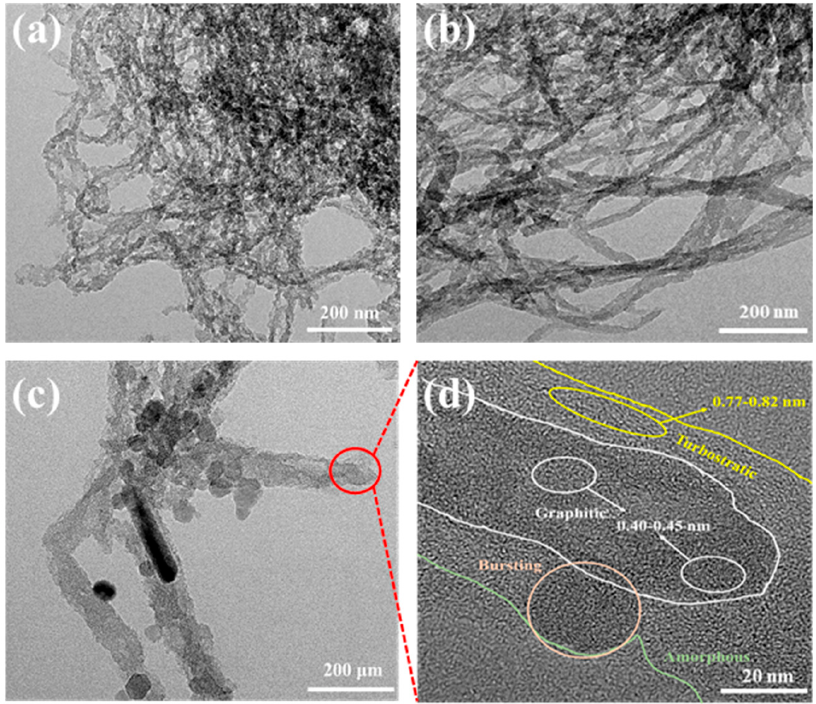
Figure 2. TEM images of ( a ) MWCNTs, ( b ) F-MWCNTs_6 and ( c ) F-MWCNTs_12 and ( d ) micro- structure of F-MWCNTs_12. ture of